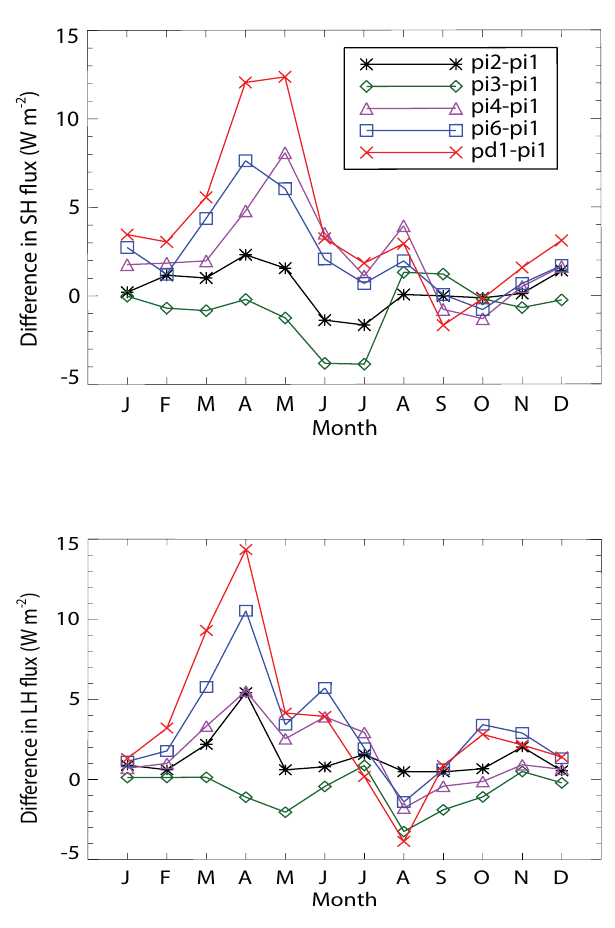
Fig. 17. Same as Fig. 11 but for sensible heat flux SH (top, Unit:Wm − 2 ) and latent heat flux LH (bottom, Unit: Wm − 2 )